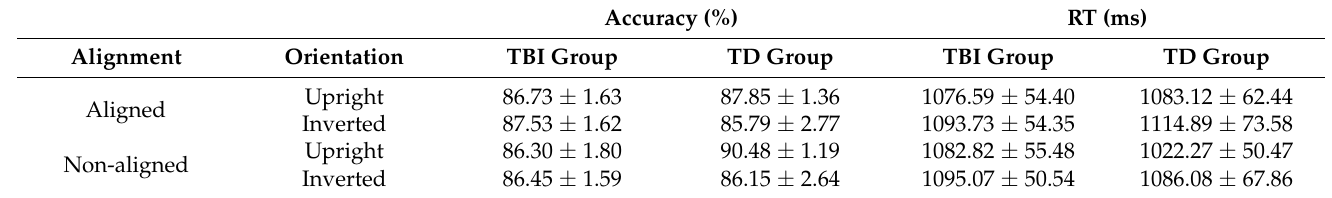
Table 2. Accuracy and Reaction Time in each experimental condition for the two groups (TBI group and TD